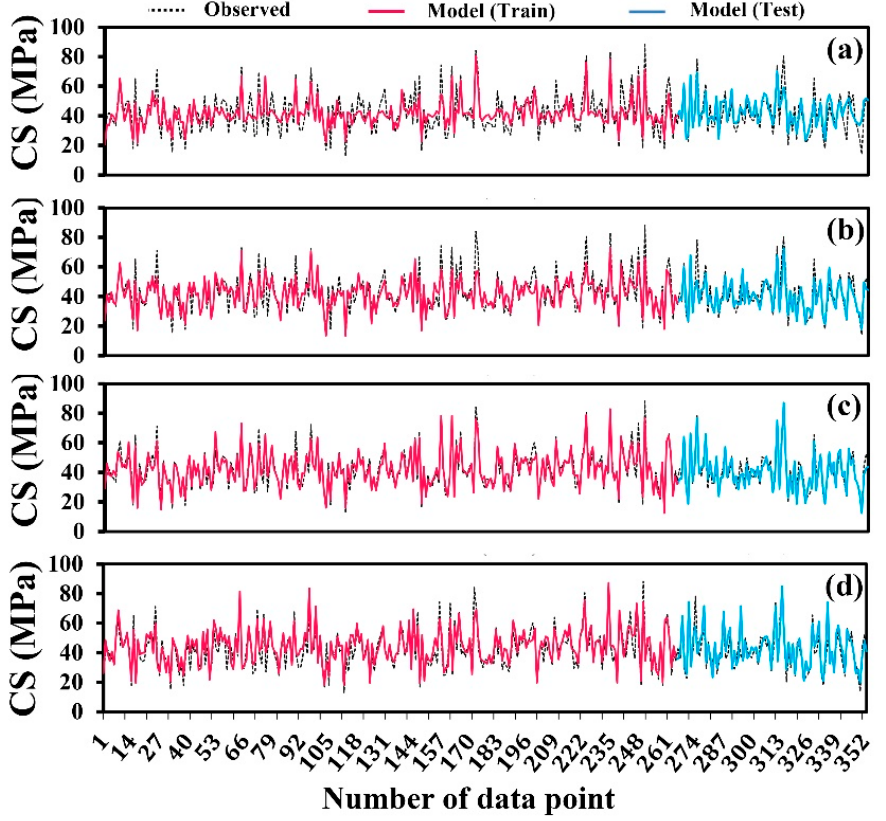
Figure 8. Comparison of predicted and experimental data in a graph CS; ( a ) GMDH; ( b ) NF; ( c ) Fuzzy-GMDH-HOA; ( d ) ELM.